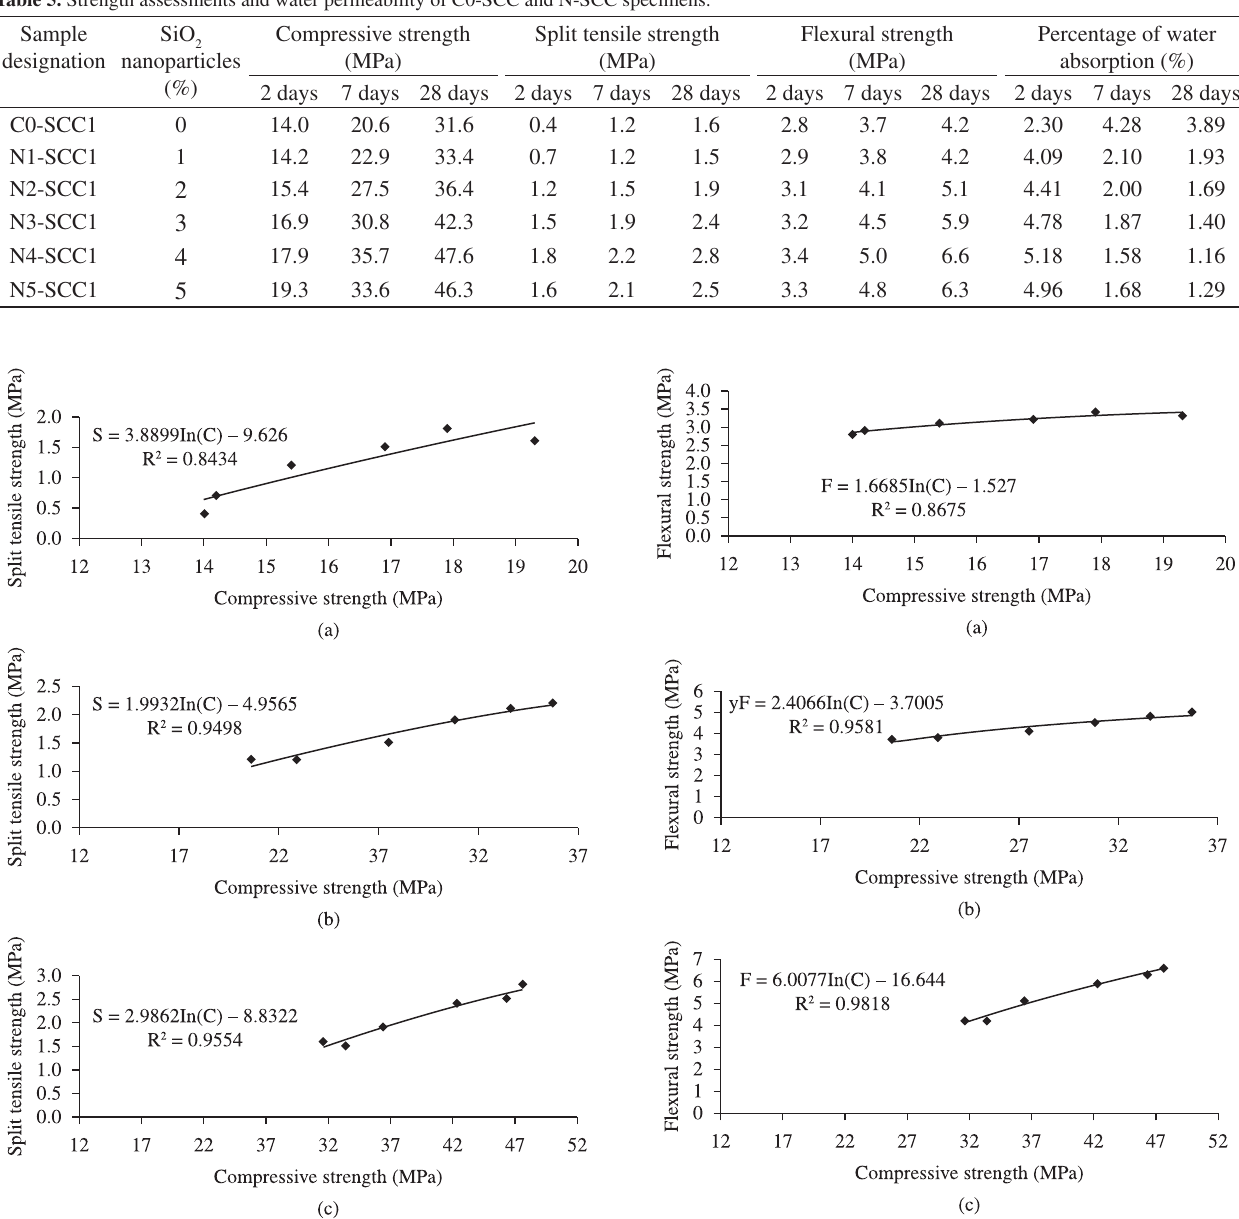
Figure 2. The relationship between flexural strength and compressive strength of the specimens cured at a) 2 days; b) 7 days; and c) 28 days. C denotes compressive strength and F denotes flexural